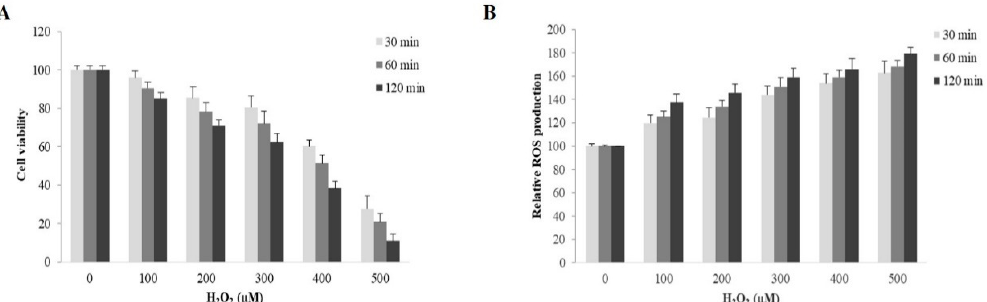
Figure 3. Evaluation of H 2 O 2 concentration and exposure time needed for cell death induction and ROS generation in ARPE-19 cells. ( A ) Cell death induction and ( B ) reactive oxygen species (ROS) generation in ARPE-19 cells treated with various concentrations of H 2 O 2 (100–500 µM) for 30, 60 and 120 min; cell viability and ROS production were measured using MTT and DCFH-DA assays, respectively. Graphs represent average cell viability and relative ROS production (mean ± SD values, n = 4).